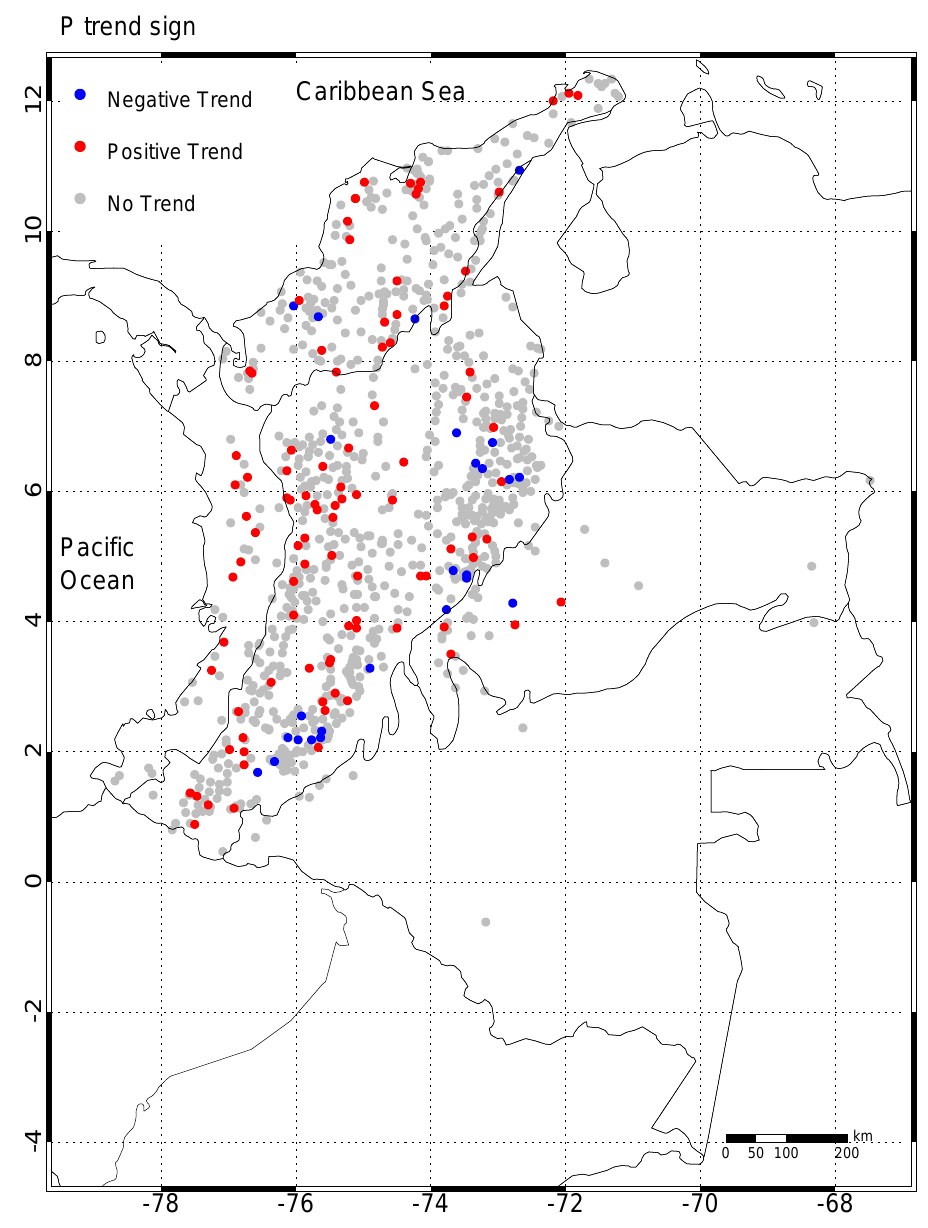
Figure 8. Map of the trend sign for P for rain gauge base dataset. Non-significant trends are plotted in